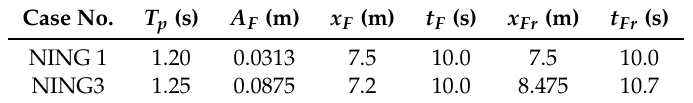
Table 1. The focusing wave inputs and the real focusing properties for the validation cases. Case No.